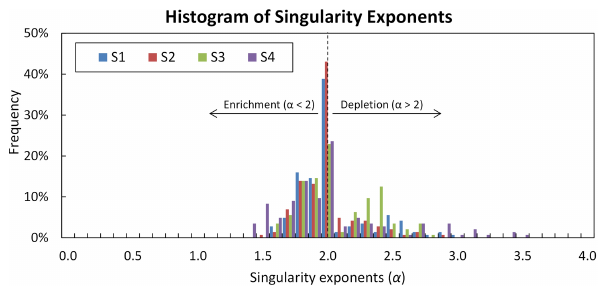
Figure 4. Histogram of singularity exponents ( α ) at the time of areal peak intensity for the four selected storm